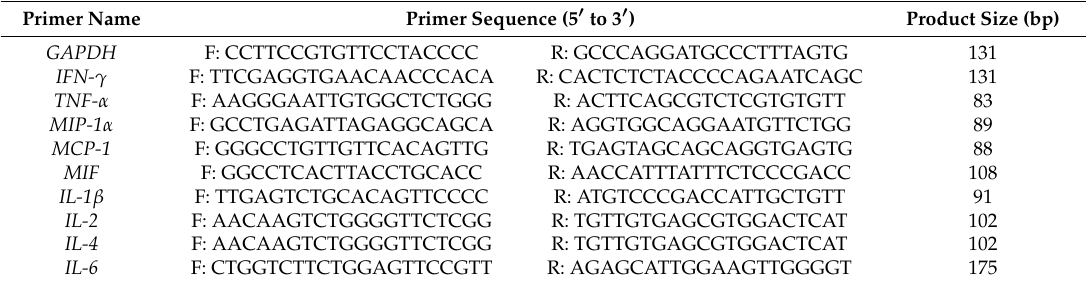
Table 6. Real-time PCR primer pairs. PCR primers used in the gene expression